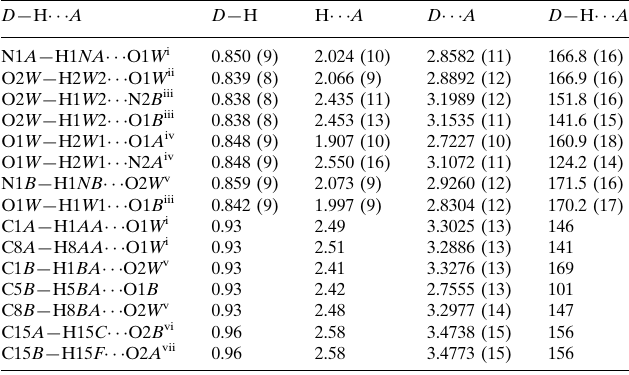
52996 measured reflections 11039 independent reflections H atoms treated by a mixture of independent and constrained refinement (cid:1) (cid:7) max = 0.45 e A˚ (cid:3) 3 (cid:1) (cid:7) min = (cid:3) 0.36 e A˚ (cid:3) 3